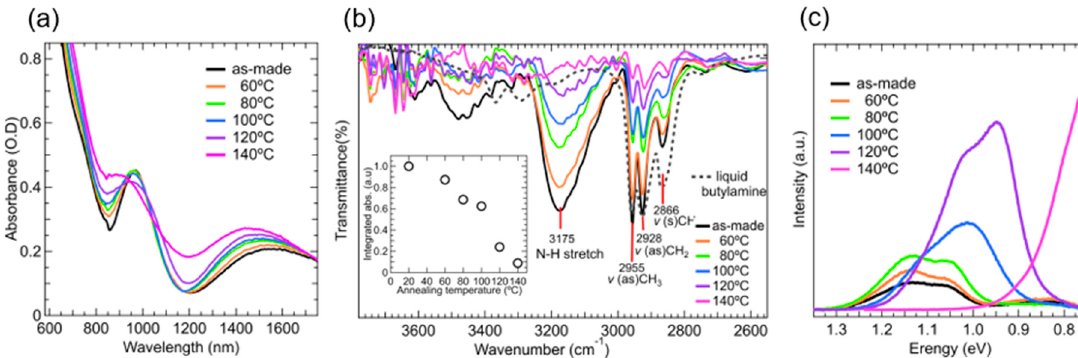
Figure 2. ( a ) Absorption spectra of the liquid-phase ligand exchanged PbS ink films; ( b ) Transmittance FTIR spectra of the PbS ink films after annealing at different temperatures. The dotted-line represents the FTIR spectrum of liquid butylamine and FTIR absorption band area vs. annealing temperature; ( c ) Steady state photoluminescence spectra of the PbS ink films annealed at different temperatures.